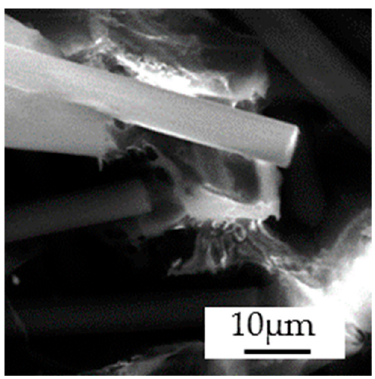
Figure 5. Morphology of the fracture of short-fiber reinforced PA6 with 30% carbon-fiber mass frac- tion.